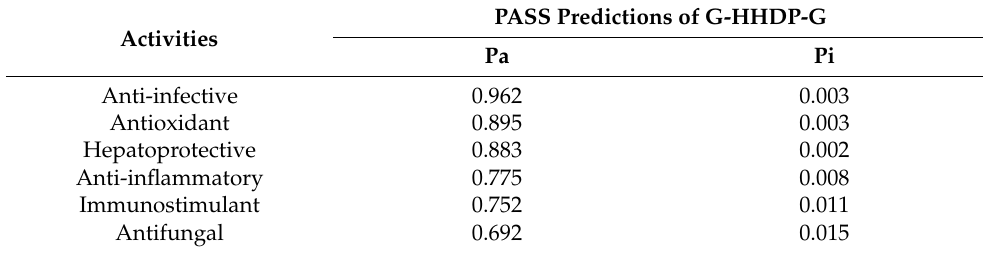
Table 1. In silico analysis of the biological activities of G-HHDP-G.